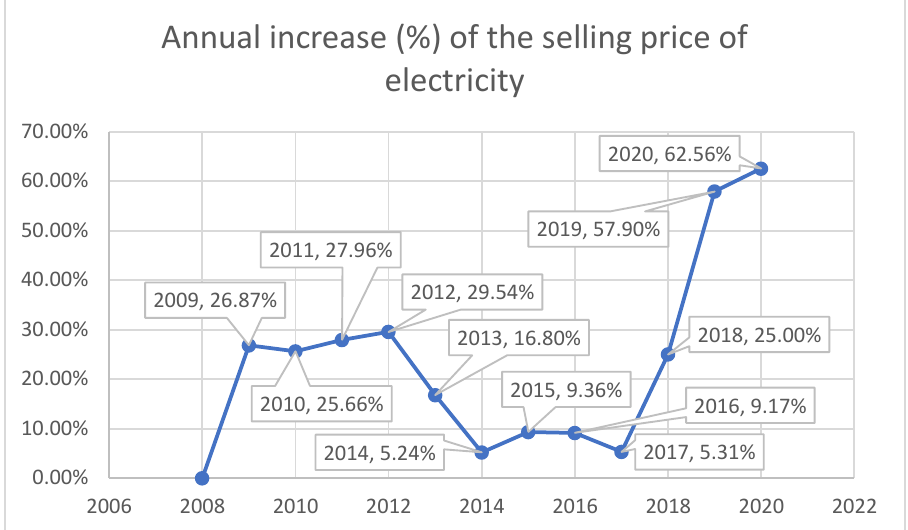
Figure 1. Annual increase (%) of the selling price of electricity. Source: author’s own compilation based on collective annual information from the President of the URE on the selling price of electricity on the competitive market.